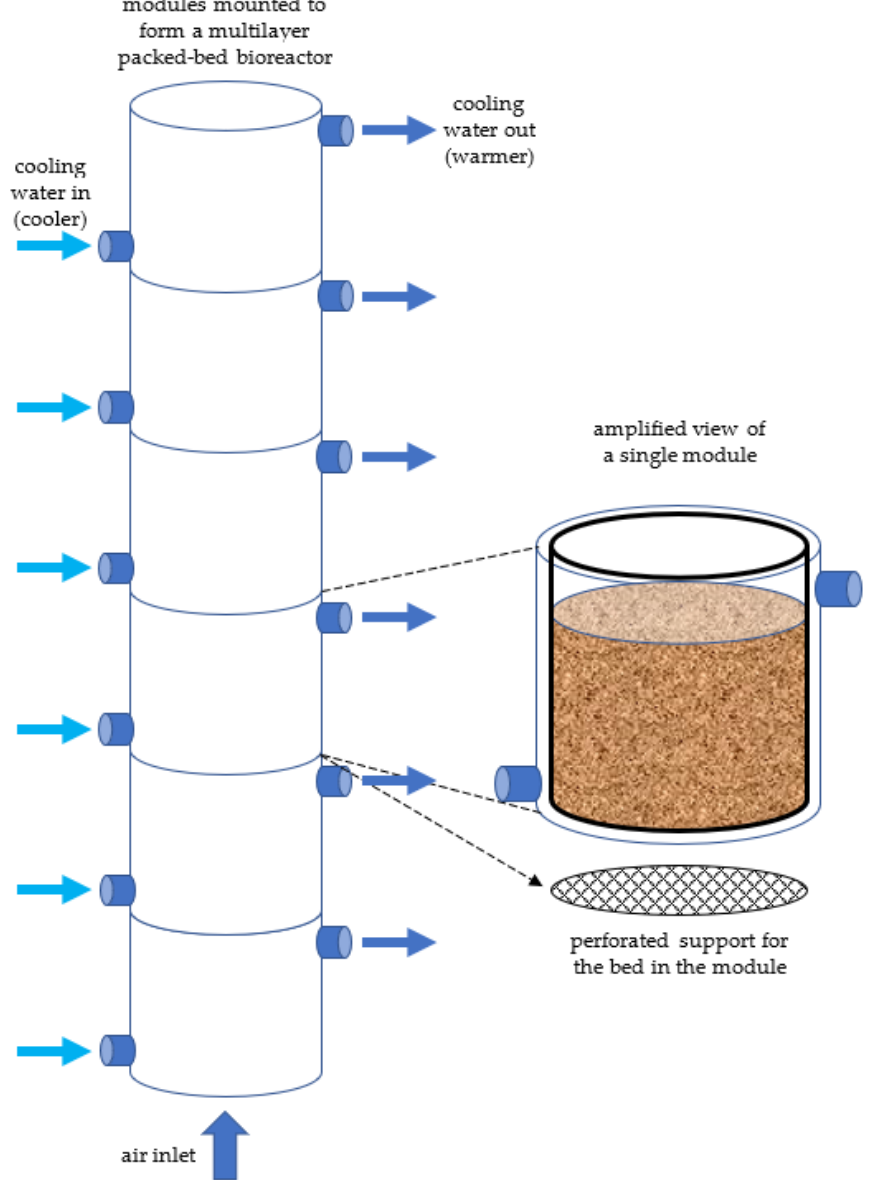
Figure 3. Basic features of a multi-layered packed-bed bioreactor made with identical water-jacketed modules stacked vertically.